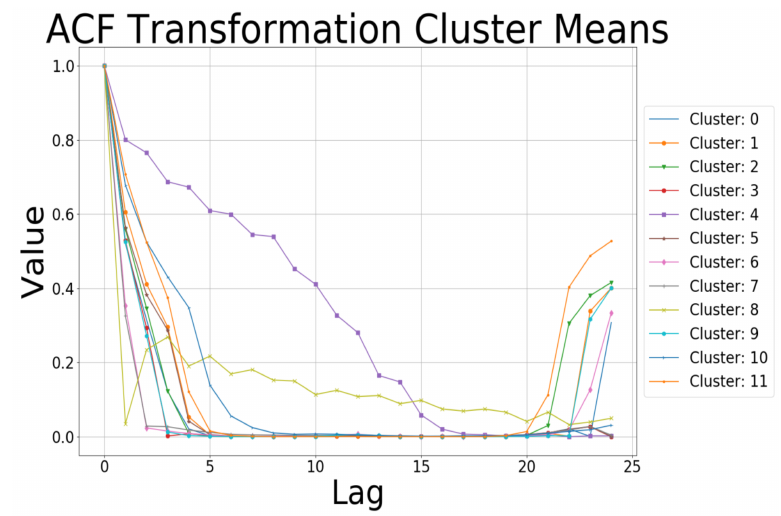
Figure 11. Plot of the 12 autocorrelation function cluster means (ACF) identified using the CDI. Clusters 4 and 8 are distinctly different showing linear decline and no recurrence. The remaining clusters exhibit a largely similar structure, with different values, and a different lag for